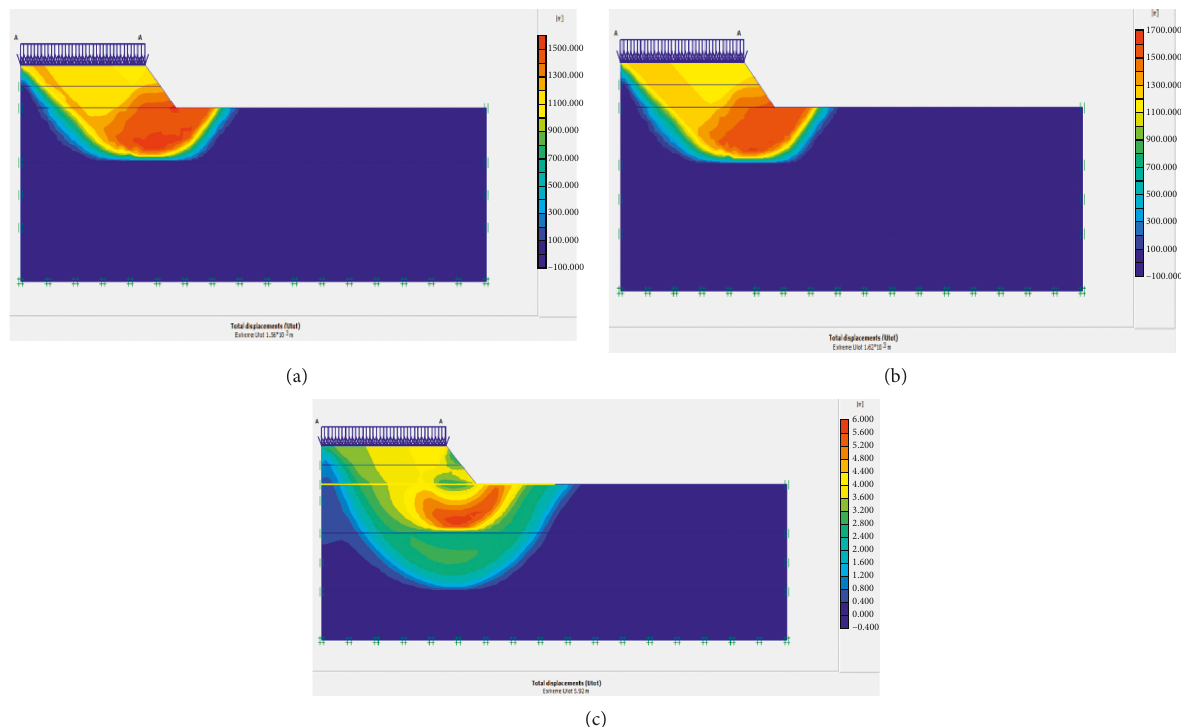
Figure 8: Total displacements of H2S1. (a) Natural soil (b) unreinforced stabilized soil. (c) Geogrid reinforced stabilized